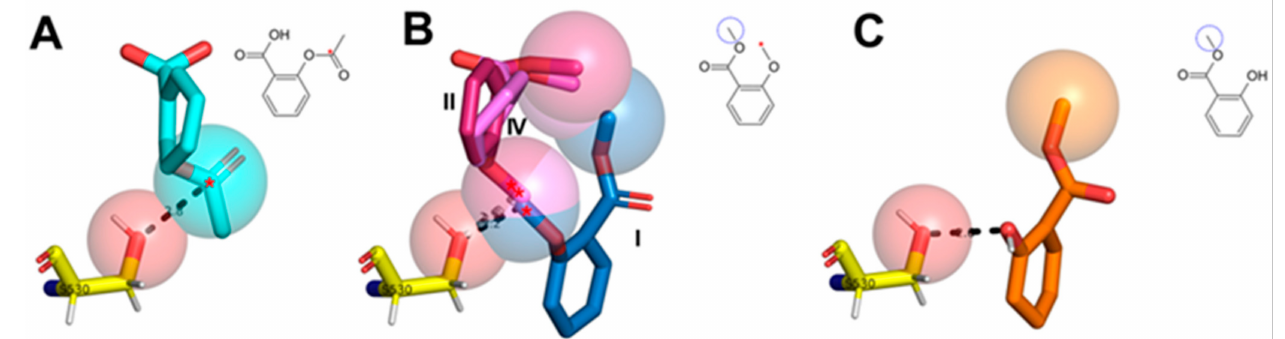
Figure 9. Docking poses for acetylsalicylic acid and salicylate related compounds from aroeira seeds at COX-1 active site. ( A )-Acetylsalycilic acid (aspirin TM , positive control); ( B )-Aroeira compound 23 (the respective docking poses I, II and IV are depicted); ( C )-Aroeira compound 16 . The contacts between the S530 residue (subjected to suicide inhibition by aspirin TM ) and the compound’s nucleophilic attack sensitive center (when present) or hydroxyl radical are both shown as dashed lines. Both at the skeletal formulas as at the docked structures, the respective groups susceptible to S530 nucleophilic attack ( red asterisk/sphere) and esterified to the original acid (dashed circle/sphere) are, all of them, highlighted when